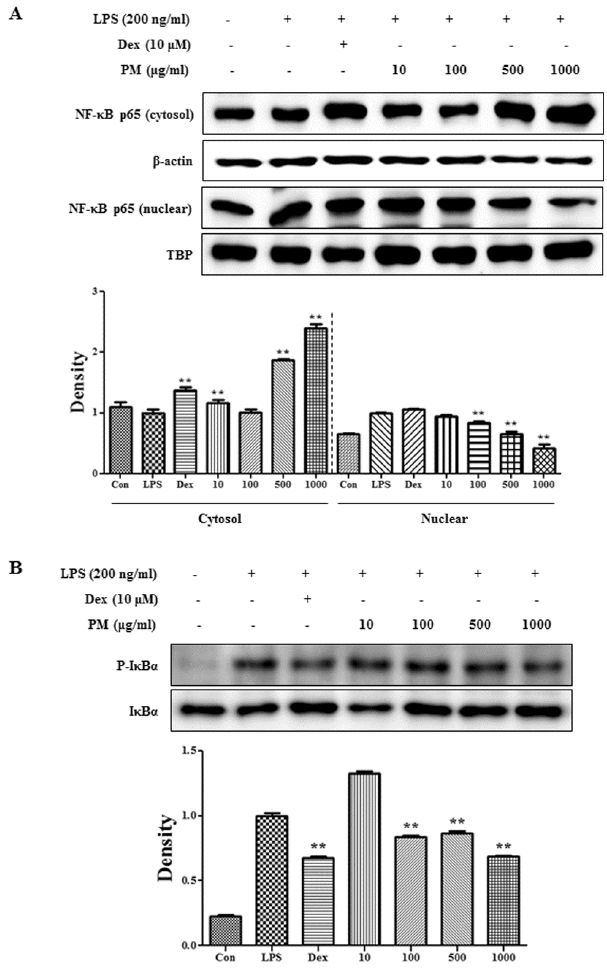
( B ) phosphorylation of I κ B α . Cells were treated with LPS alone or with LPS and PM for 30 min ( I κ B α ) or 1 h ( NF- κ B ). Proteins in the cytosol or nucleus were analyzed by Western blotting. ** p < 0.001 were calculated via comparisons with the LPS-stimulation